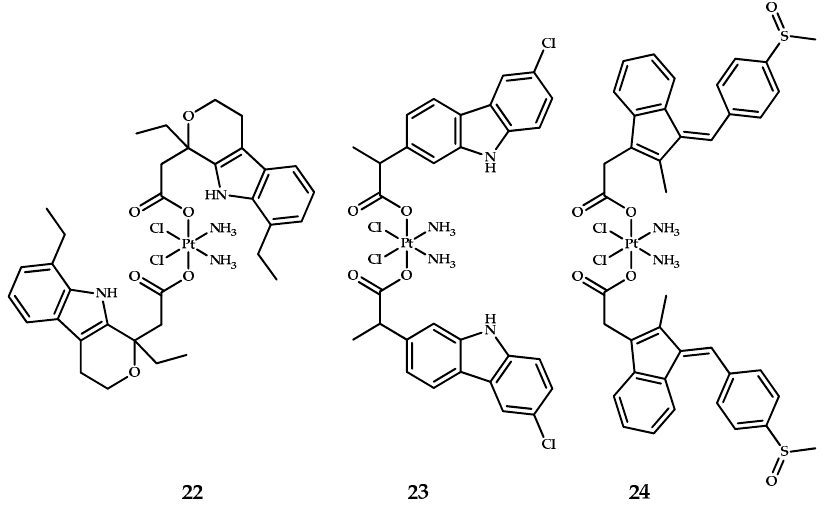
Figure 11. Platinum(IV) prodrugs with etodolac 22 , carprofen 23 and sulindac 24 moieties as axial ligands. Table 11. Antiproliferative activity of cisplatin and prodrugs 22–24 on MCF-7 (breast cancer), A549 (lung carcinoma), HeLa (cervical cancer), and MCR-5 (embryo fibroblast) cell lines. LogP values and cellular uptake in MCF-7 cells are also shown. Compound/Cell